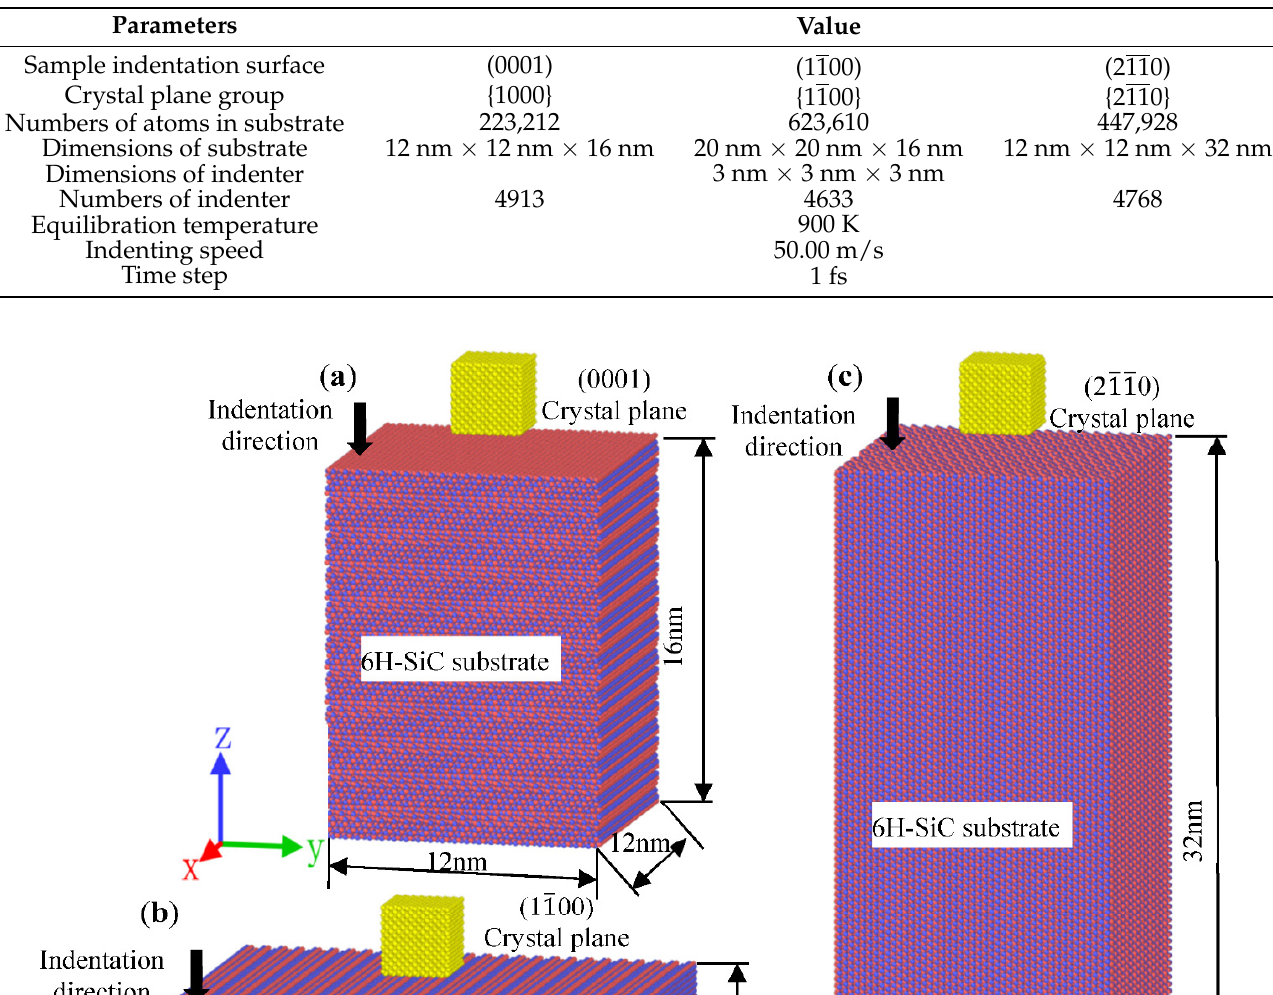
Table 1. Molecular dynamics simulation parameters.